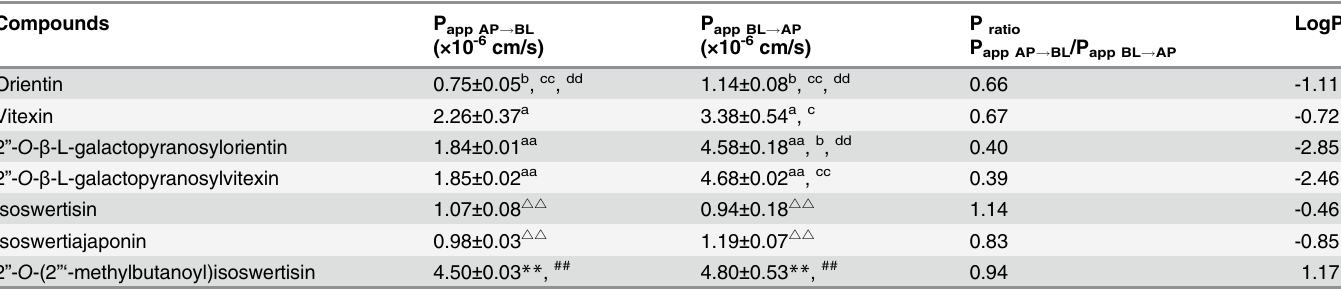
Table 2. The bidirectional P app values of the seven individual fl avonoids and their LogP.